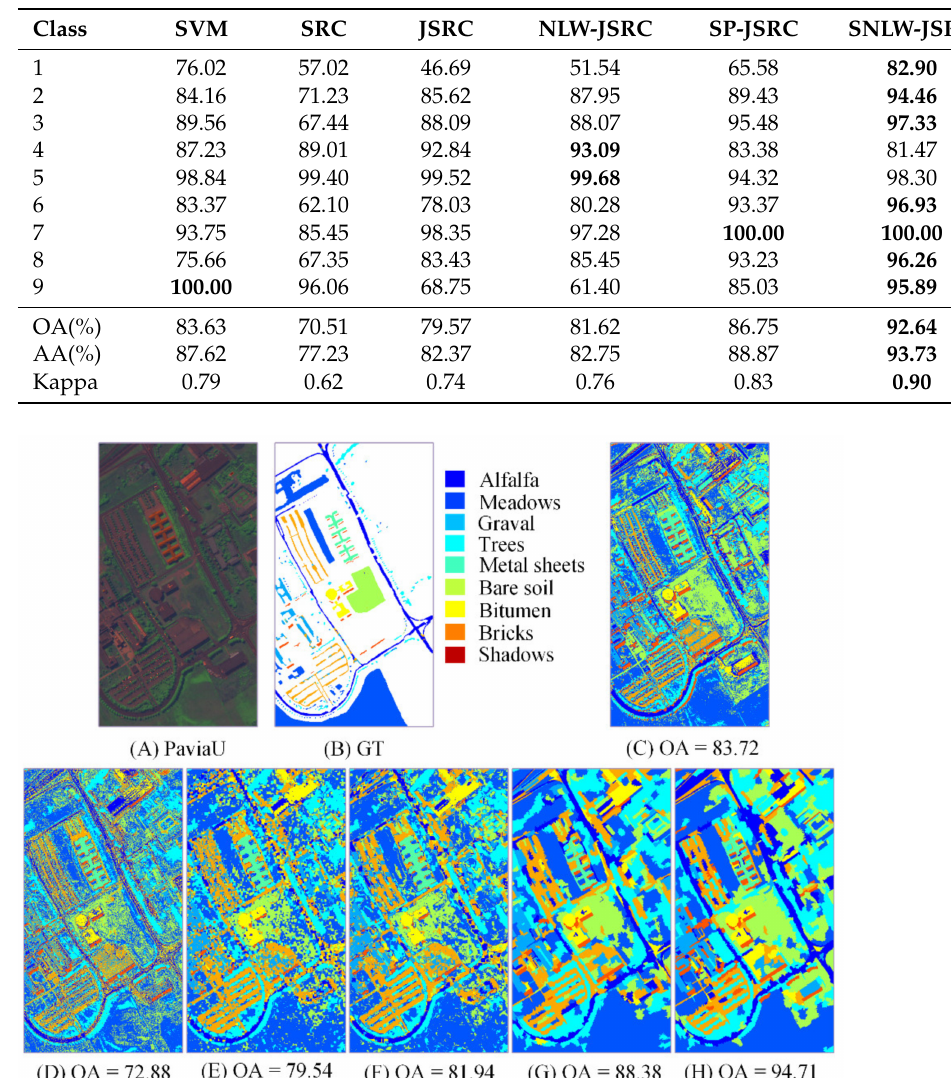
Figure 5. PaviaU image: ( A ) composite color image and ( B ) ground truth; estimation map obtained by ( C ) SVM; ( D ) SRC; ( E ) JSRC; ( F ) NLW-JSRC; ( G ) SP-JSRC; ( H )